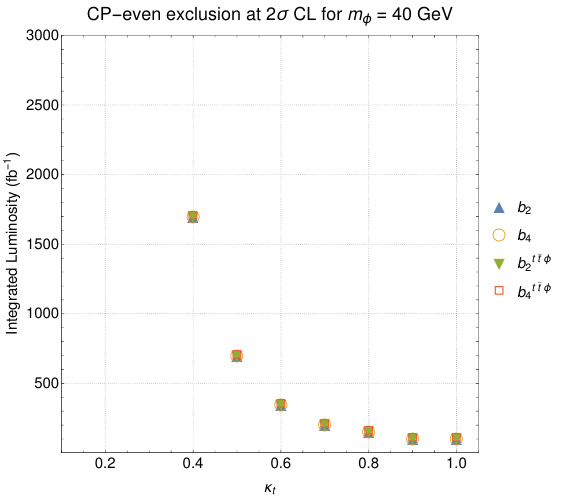
Figure 15. Luminosity needed to exclude (cid:20) t at the 2 (cid:27) level for the pure CP-even case (scenario 1), for a CP-even scalar boson mass of 40